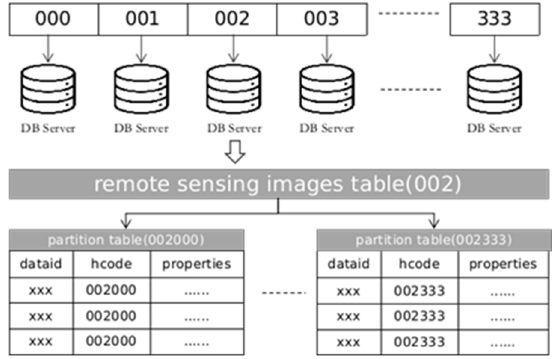
Figure 5. Structure of two-tier distributed spatial index.